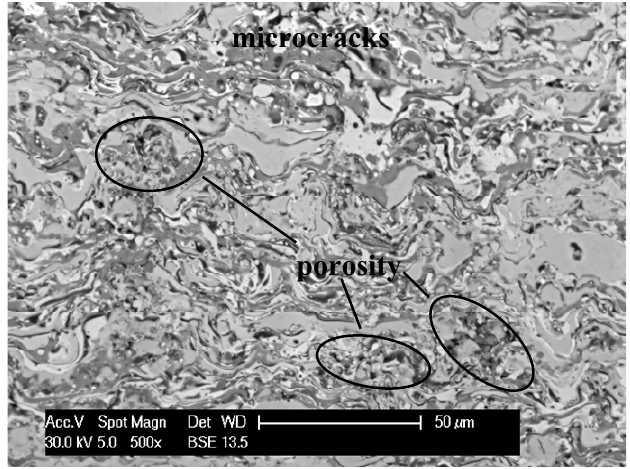
Figure 3. Microstructure on the cross section of the D-gun sprayed Fe-Al type coating deposited in “low” value of the detonation energy (characteristic porosity and microcracks near top of the coating).